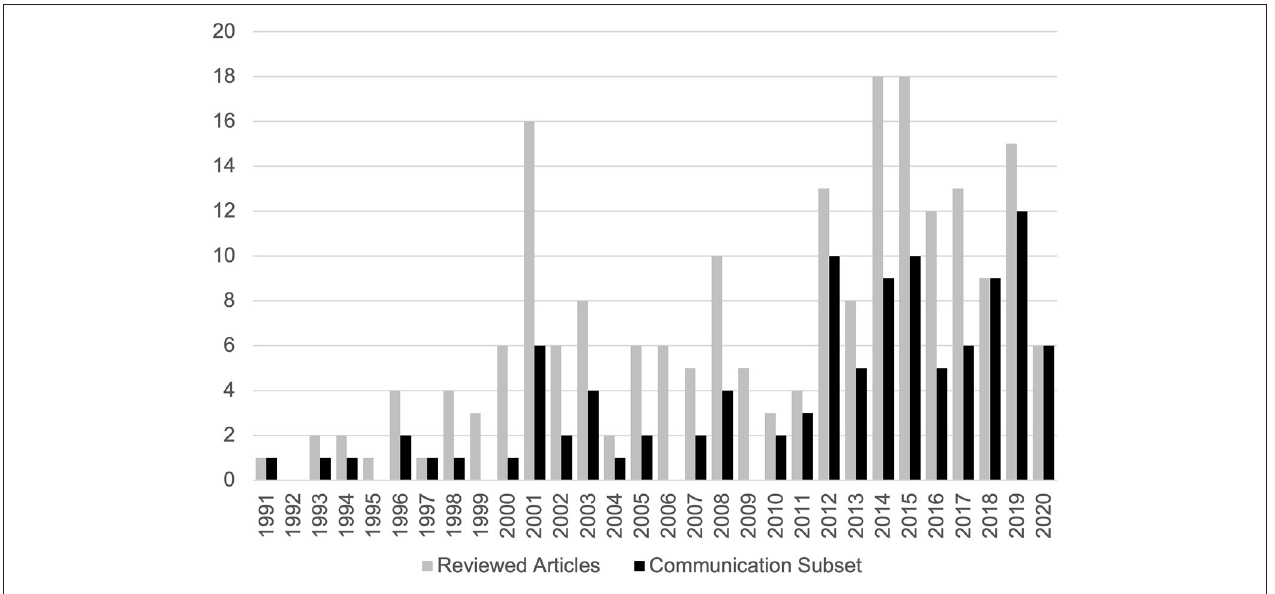
FIGURE 2 | Distribution of reviewed articles and communication subset by year.